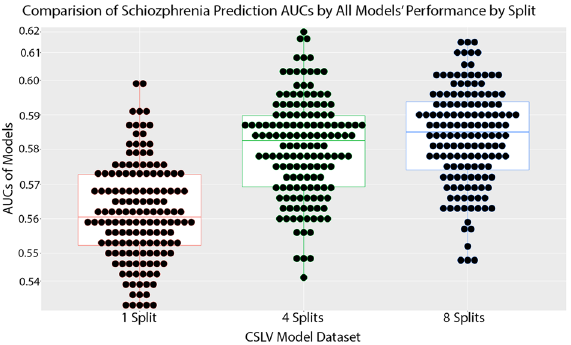
Figure 3. This plot represents the average performance of 150 models for each split type for a total of 450 models.